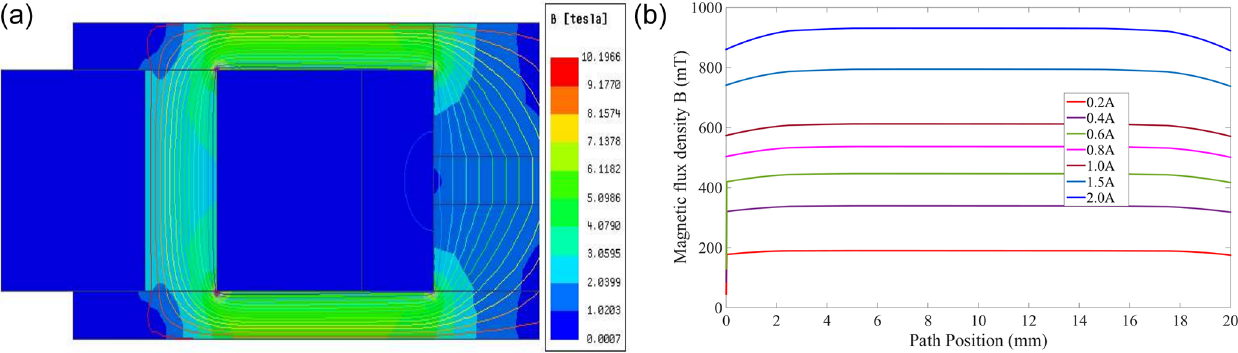
Figure 5. Single controlled channel magnetic circuit characteristics: (a) magnetic flux intensity cloud and (b) magnetic flux intensity for different